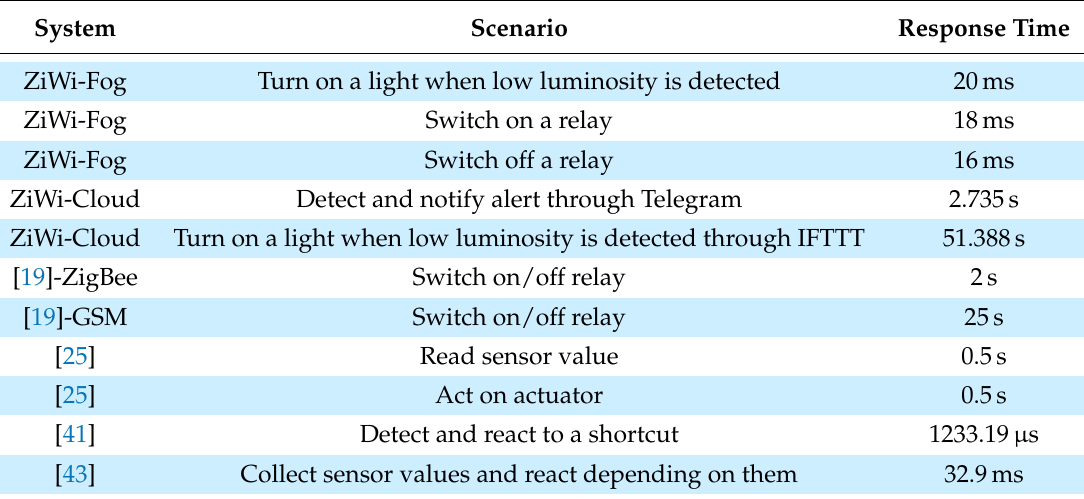
Table 8. Response time comparison of ZiWi with other state-of-the-art